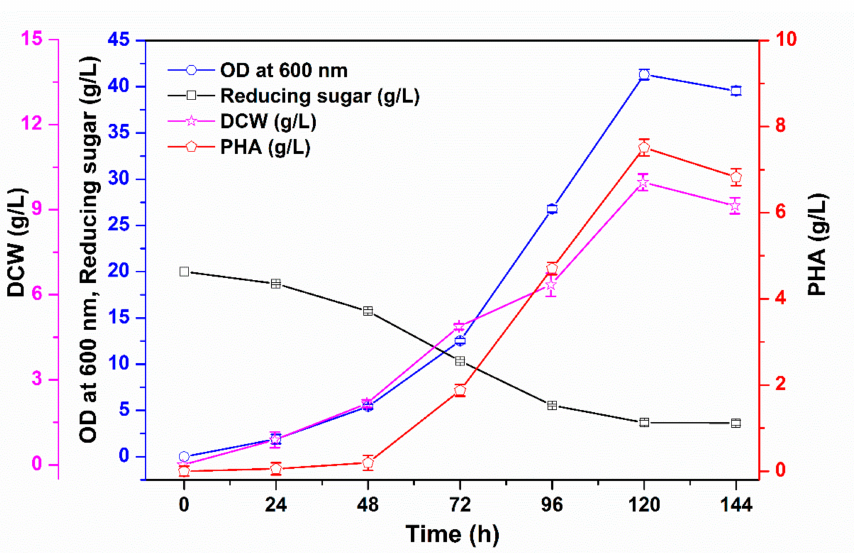
Figure 2. Time profile of OD at 600 nm, DCW, PHA accumulation, and substrate utilization by Cupriavidus necator KCTC 2649 using 0.3 N HCl DCB hydrolysate as the carbon source in a flask culture. Data are shown as mean values ± standard deviation ( n =